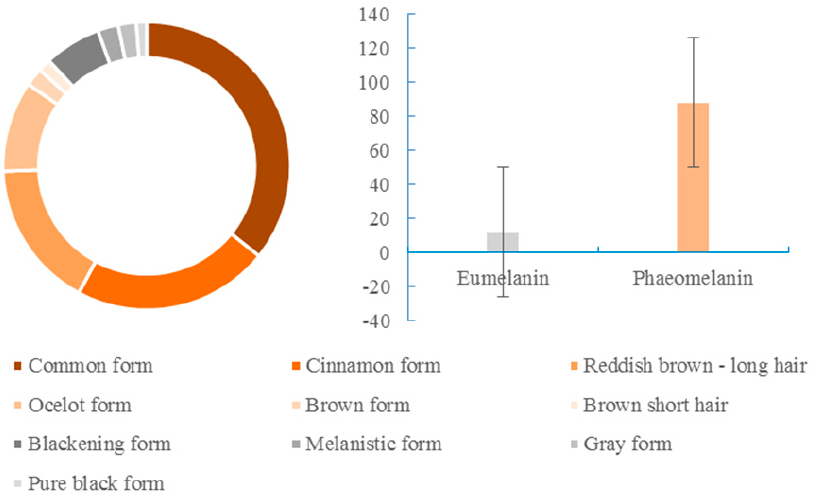
Figure 3. Proportion of eumelanin and phaeomelanin in natural populations of the Asian golden